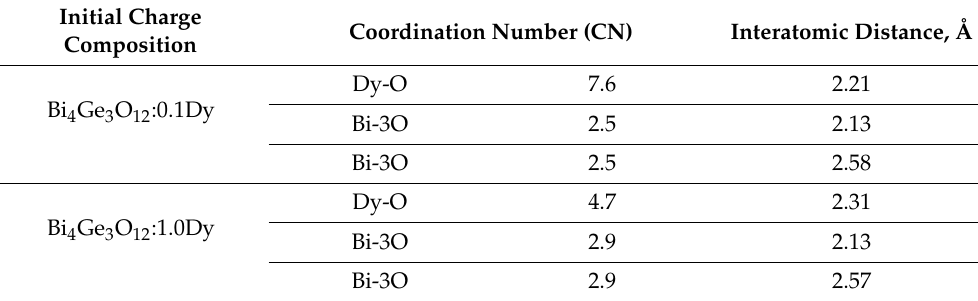
Table 9. Results of single-sphere EXAFS fit for BGO:Dy crystals.